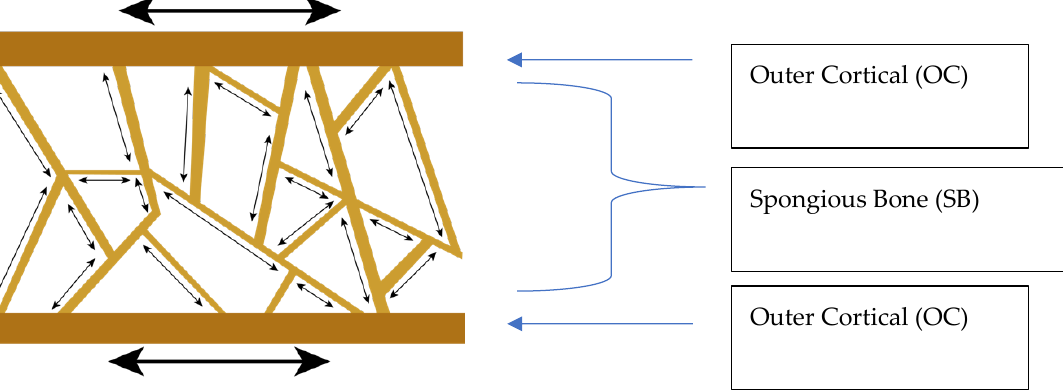
Figure 1. Schematic overview of a long bone under mechanical deformation. Thick double arrows show the deformation of the outer cortical bone (OC), thin double-arrows show the deformation and relative spatial changes in the spongious bone (SB)